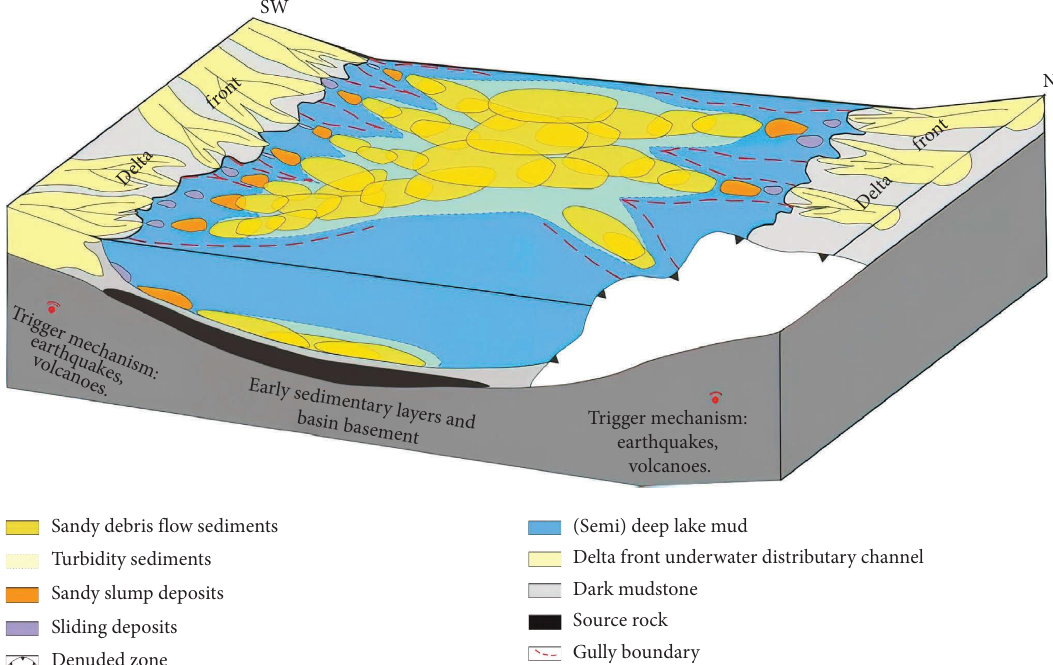
Figure 8: Schematic diagram of the gravity fow deposition model of Chang 6 in Yanchang